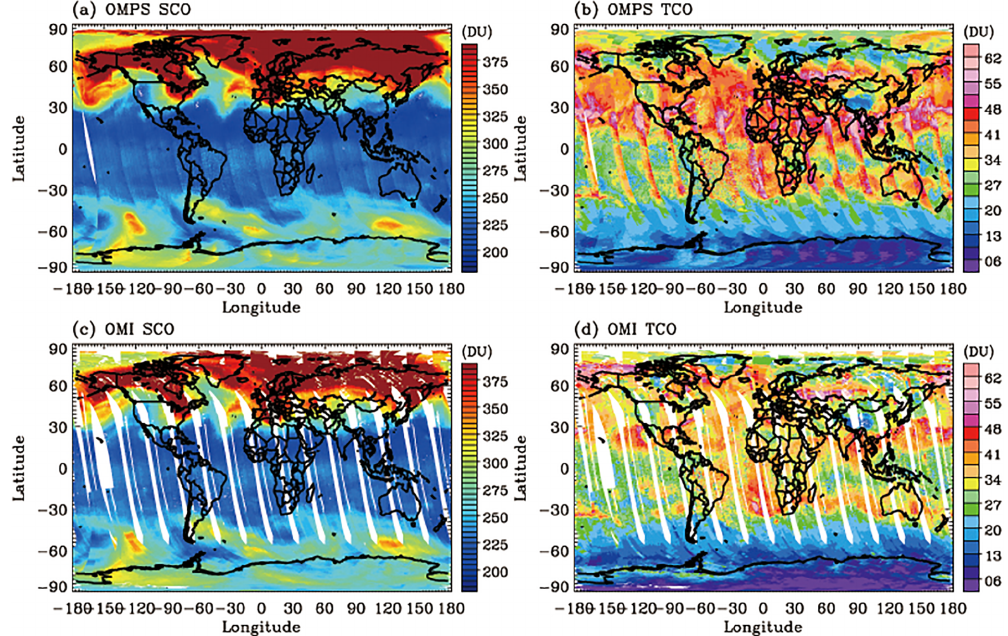
Figure 5. Maps of stratospheric and tropospheric ozone column on 14 March 2013, retrieved from OMPS (a, b) without any correction and OMI (c, d) measurements,